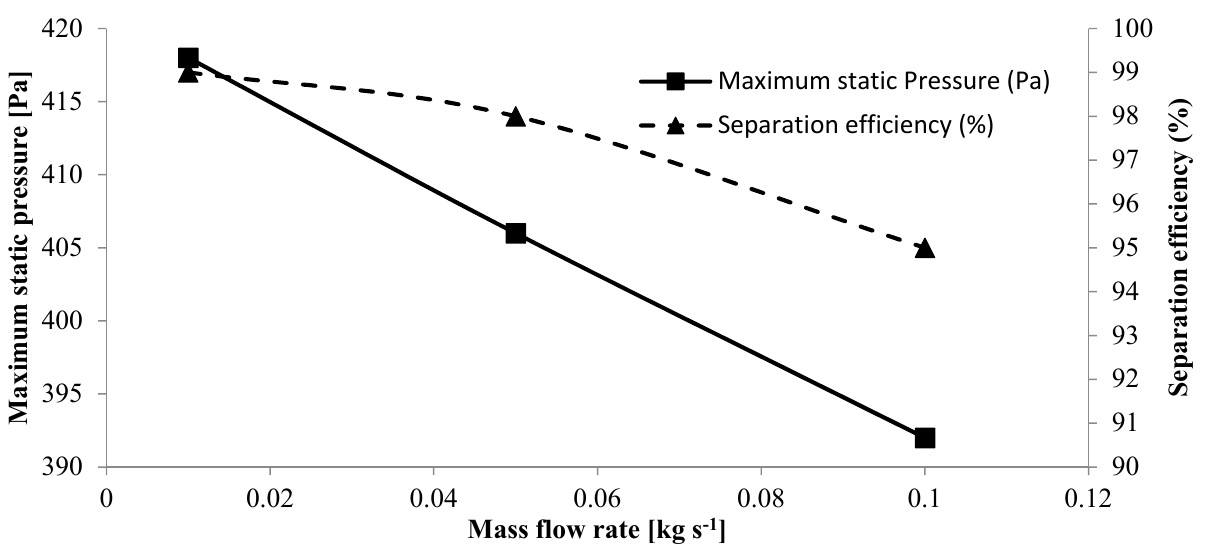
Figure 7. Maximum static pressure and separation efficiency variations in various mass flow rates.